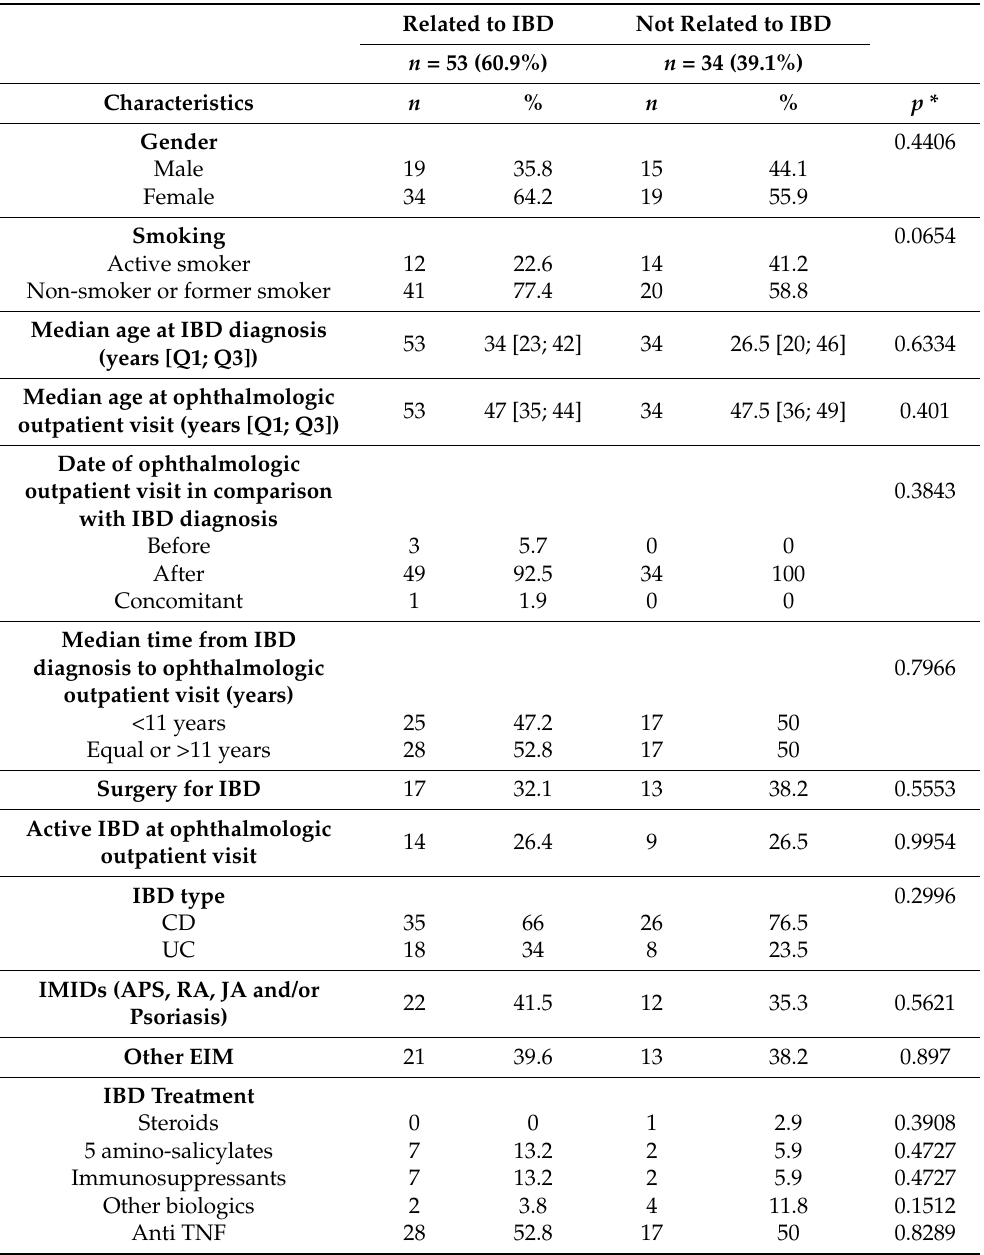
Table 3. Risk factors for ocular